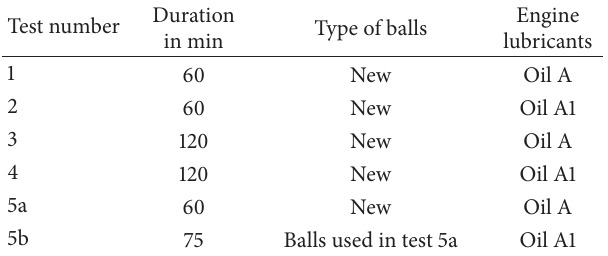
Table 2: Test matrix of the